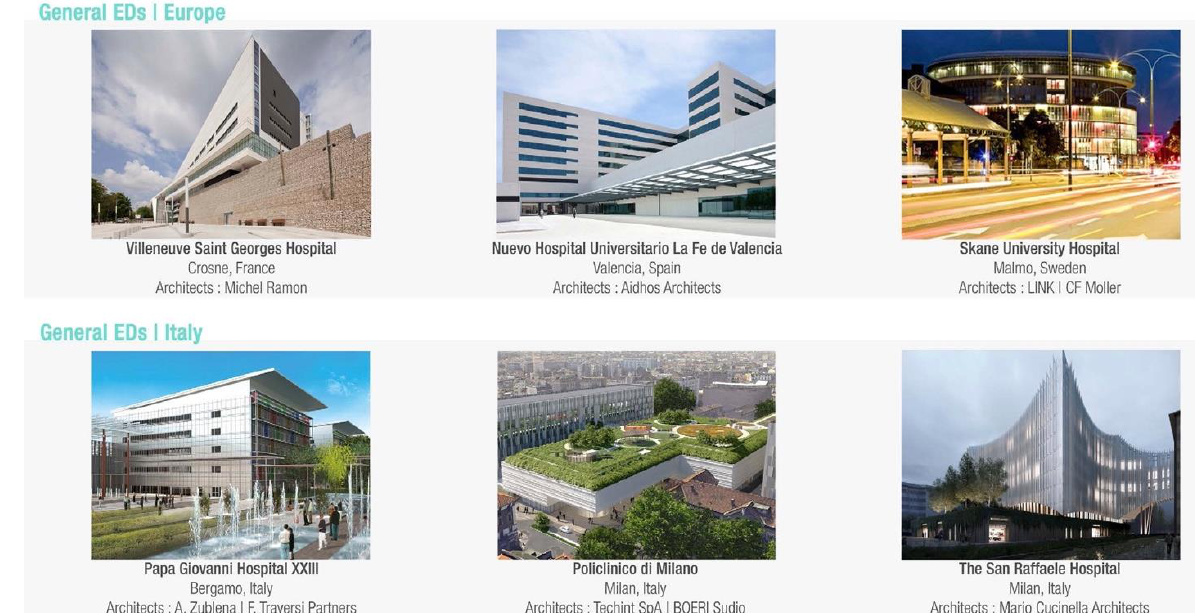
Figure 7. HBED Case studies Analysis.